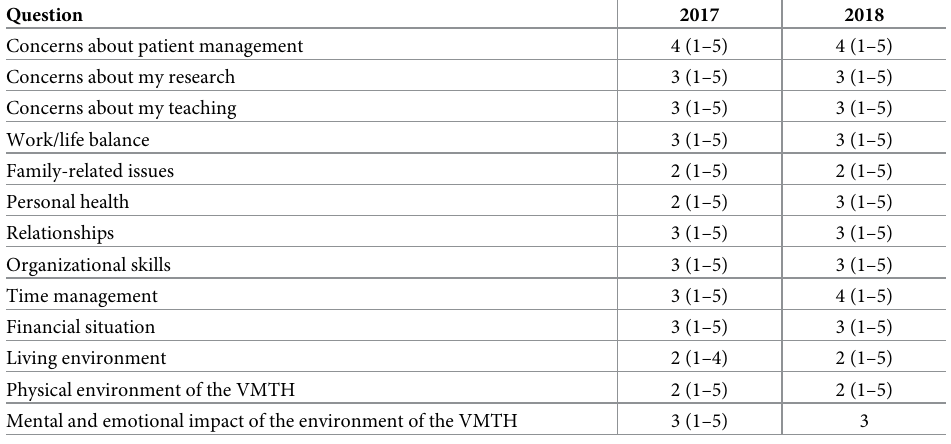
Table 4. Median (range) scores for perception of stress regarding various aspects of training among house officers in 2017 (n = 60) and 2018 (n =